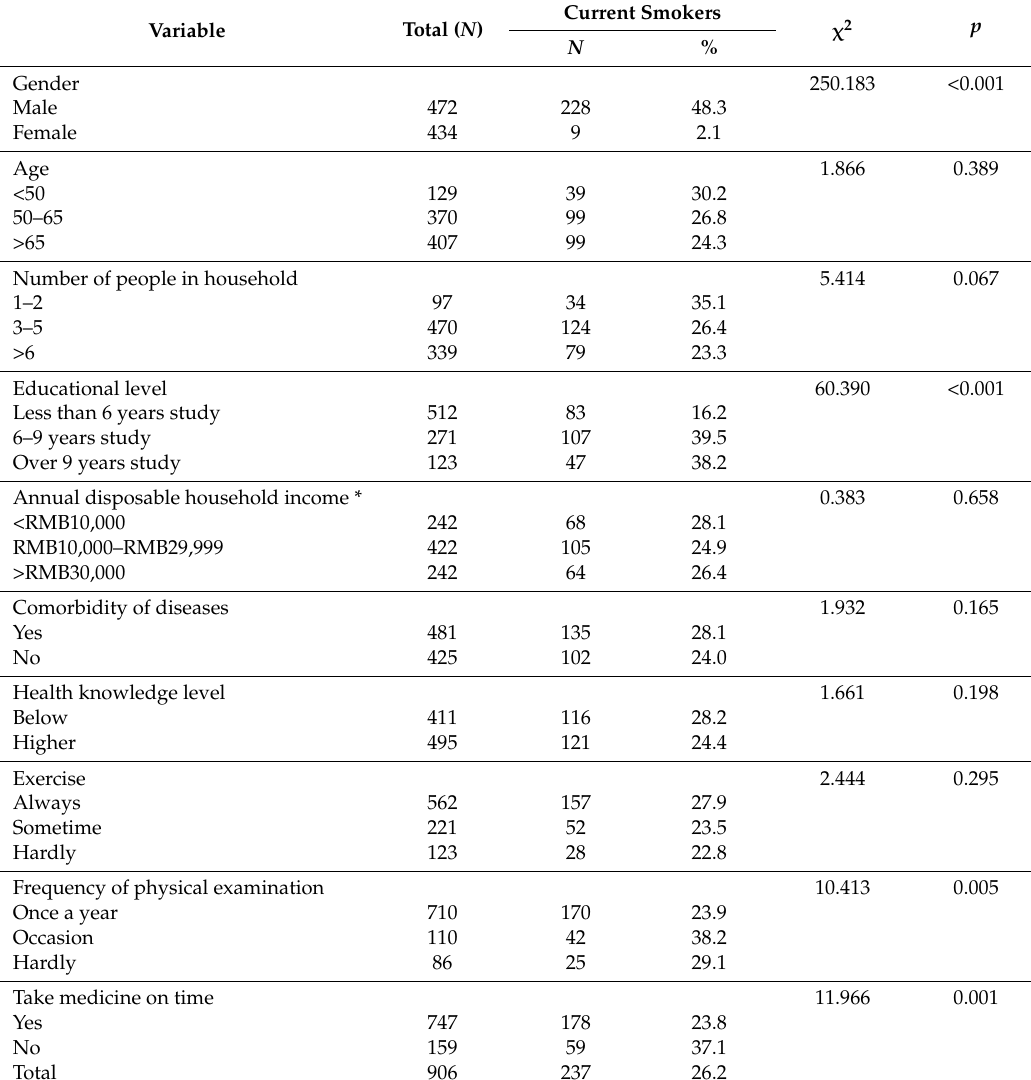
Table 1. Current smoking prevalence categorized by demographics, health status, health knowledge, and